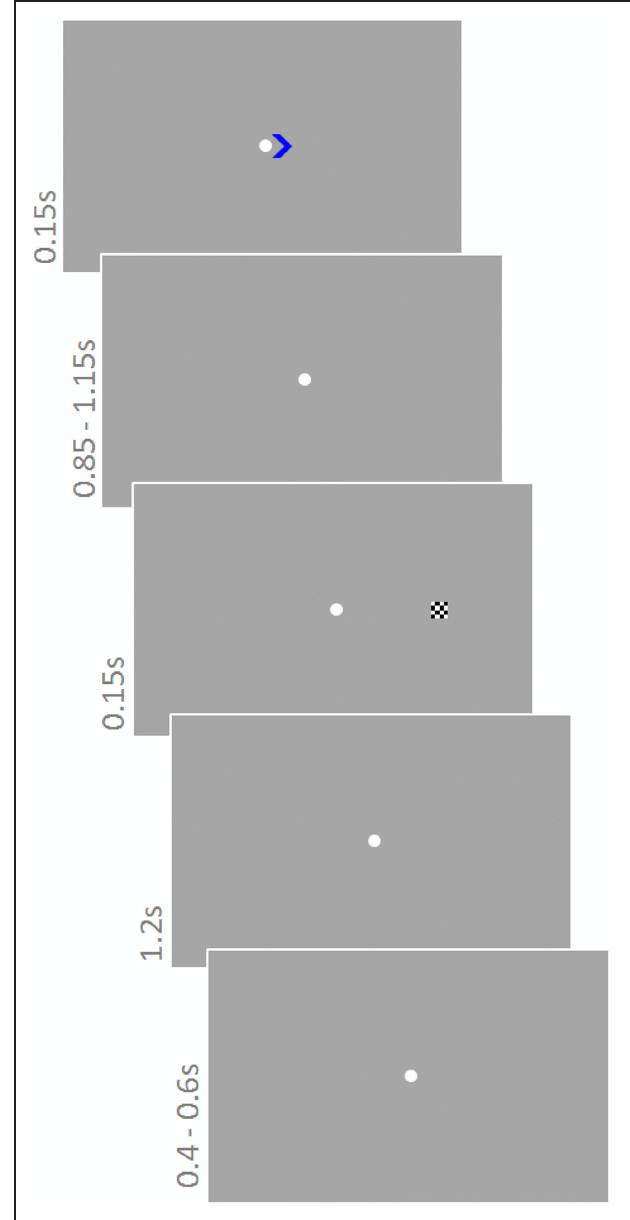
FIGURE 3 | Posner task. A cue pointing to the left or right indicated where the upcoming target would appear. Cues were valid or invalid with different probabilities depending on the color of the cue (green or blue). One color signaled 80% validity, whereas the other signaled 65% validity. The task was to respond to the target as soon as it appeared with a ‘left’ or ‘right’ button press. Sound was presented